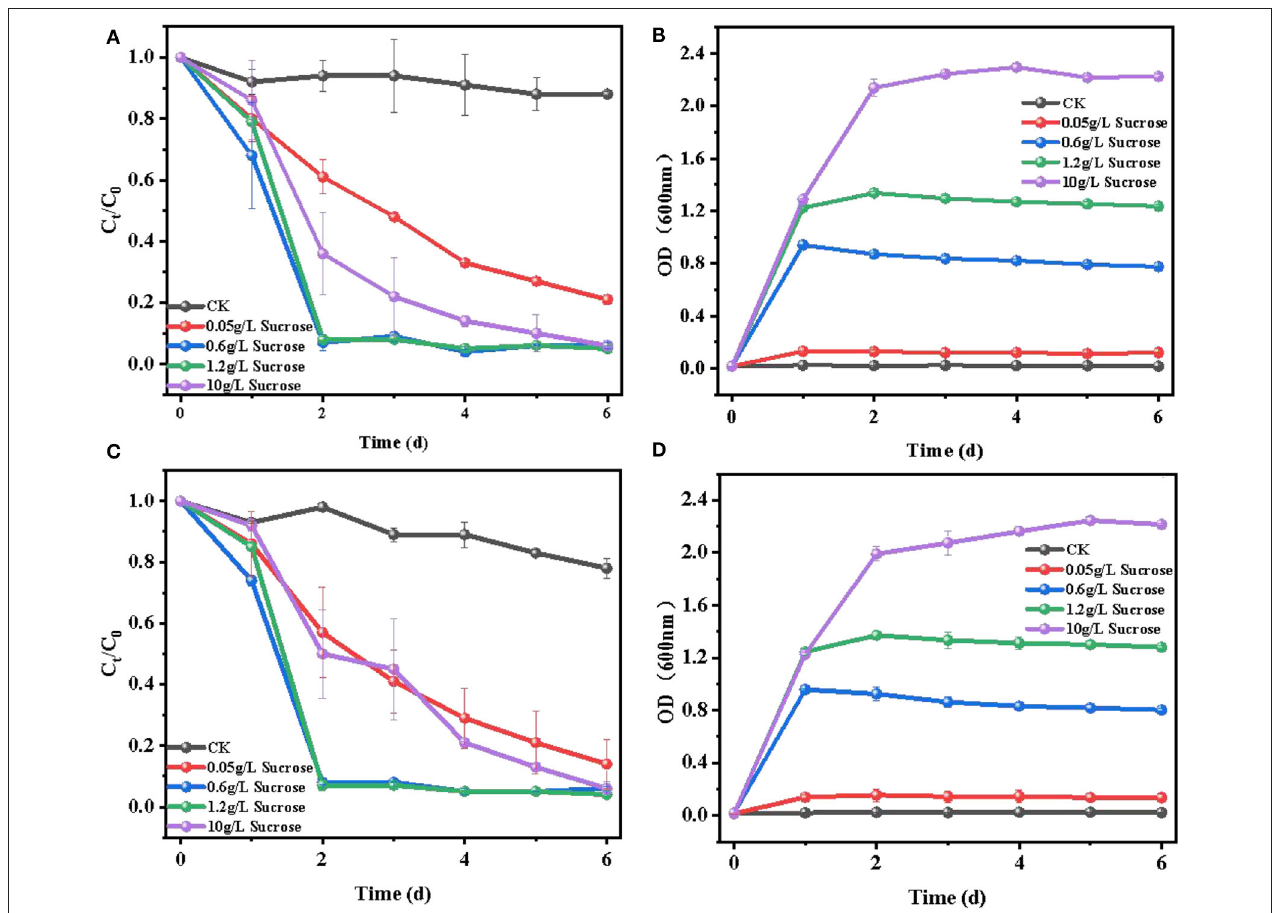
FIGURE 3 | Effects of 0.05–10 g/L sucrose concentration on the degradation of E2: (A) degradation efficiency of E2 by C. utilis CU-2; (B) cell growth of C. utilis CU-2, measured with OD at λ = 600nm; (C) degradation efficiency of E2 by L. casei LC-1; (D) cell growth of L. casei LC-1, measured with OD at λ = 600nm. CK represented the control group without carbon source added ([E2] 0 = 10 µ M, the initial pH = 7.0 ±